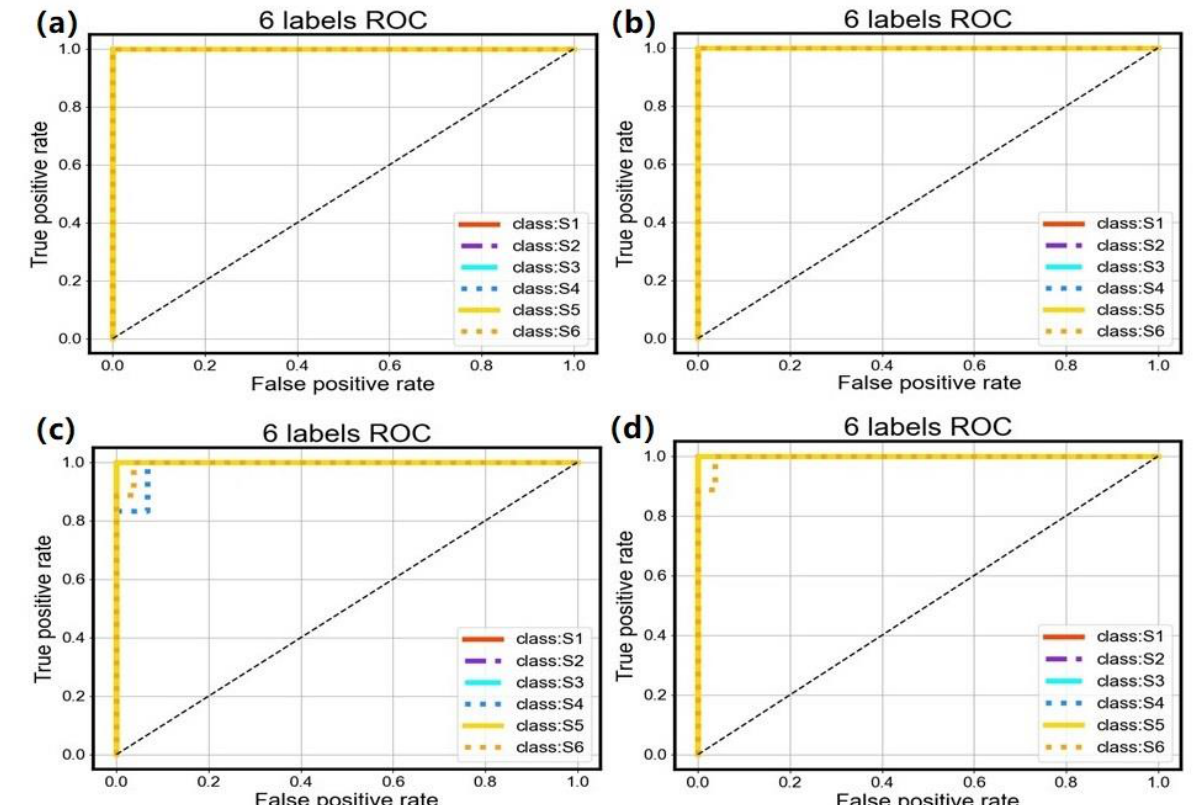
Figure 7. Overall receiver operating characteristics (ROC) curve of lightGBM showing the true positive and false-positive: ( a ) based on original data, ( b ) based on the PCA data, ( c ) based on the ISOMAP data, and ( d ) based on the UMAP data. Class S1 refers to LRW samples, class S2 refers to LE, class S3 refers to ICRE, class S4 refers to AeroE, class S5 refers to ANE, and class S6 refers to MBRE.